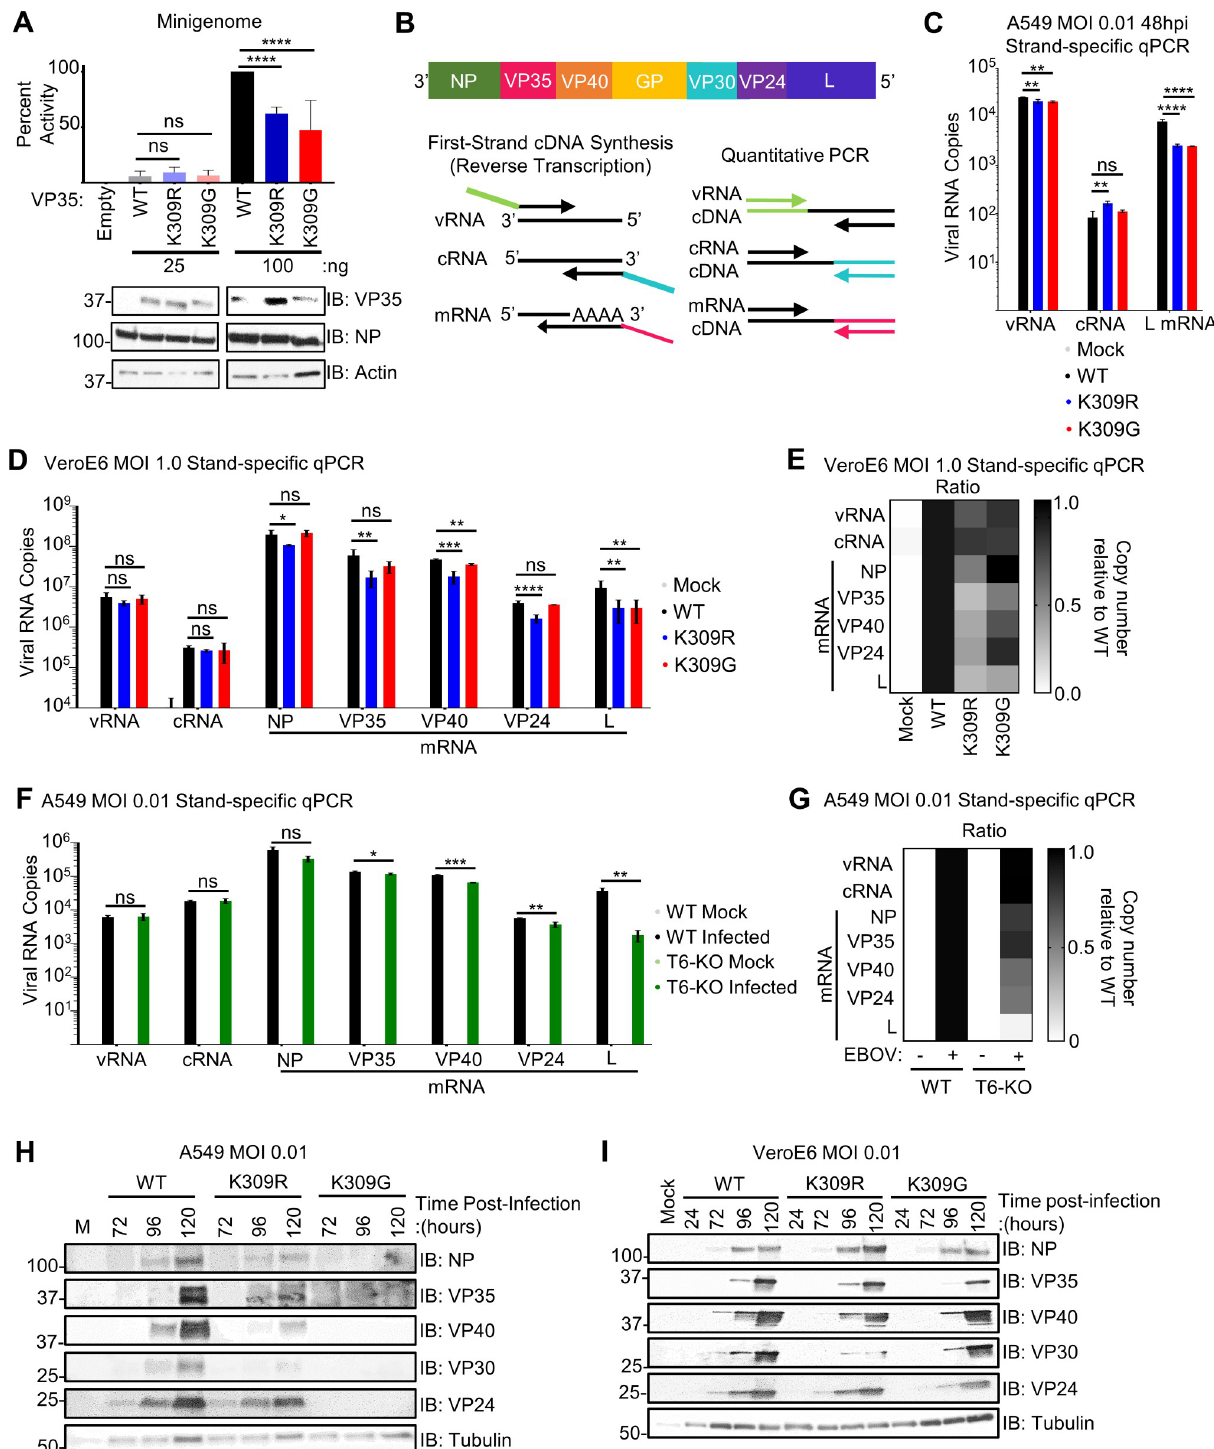
Fig 5. Ubiquitination of VP35/309 enhances viral transcriptase function. ( A ) Minigenome components (renilla, VP30, NP, L, T7 polymerase, and EBOV minigenome luciferase plasmid) were co-expressed with 25 or 100 ng of empty vector (pCAGGS) or VP35/wt, -K309R, or K309G in 293T cells. At 50 hours post-transfection, the cells were lysed to measure luciferase and evaluate protein expression. Quantification is from two independent experiments conducted in biological triplicate. ( B ) Graphical representation of the EBOV genome and the strand-specific qPCR approach. ( C ) A549 cells were infected with rEBOV-eGFP-VP35/wt (black), -K309R (blue), or -K309G (red) viruses at an MOI of 0.01 PFU/cell for 48 hours and RNA was